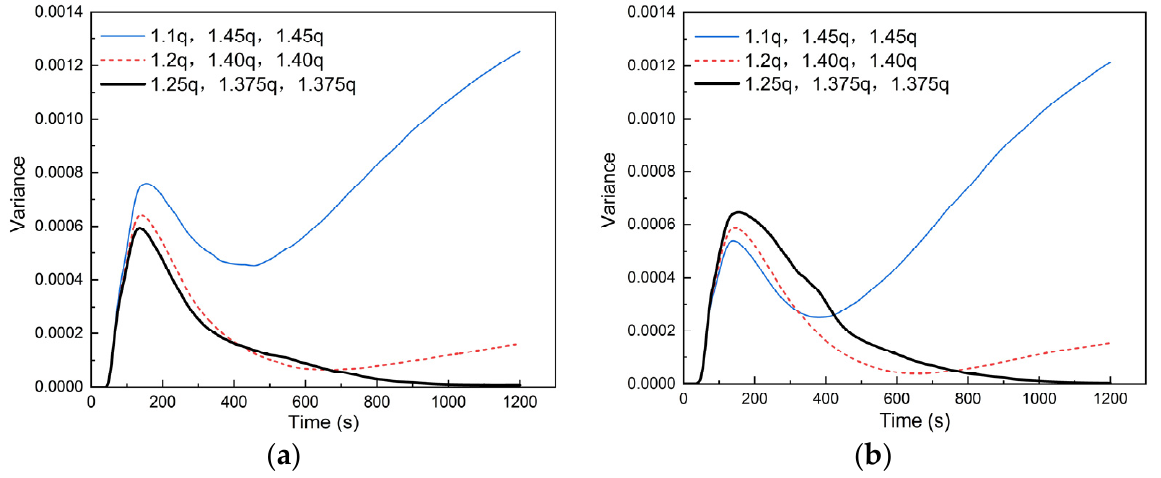
Figure 28. Variance of outflow percentage of the u-shaped weir tundish with non-uniform increasing casting flow rate under single-strand blockage conditions: ( a ) strand 1 blockage, ( b ) strand 2 blockage.